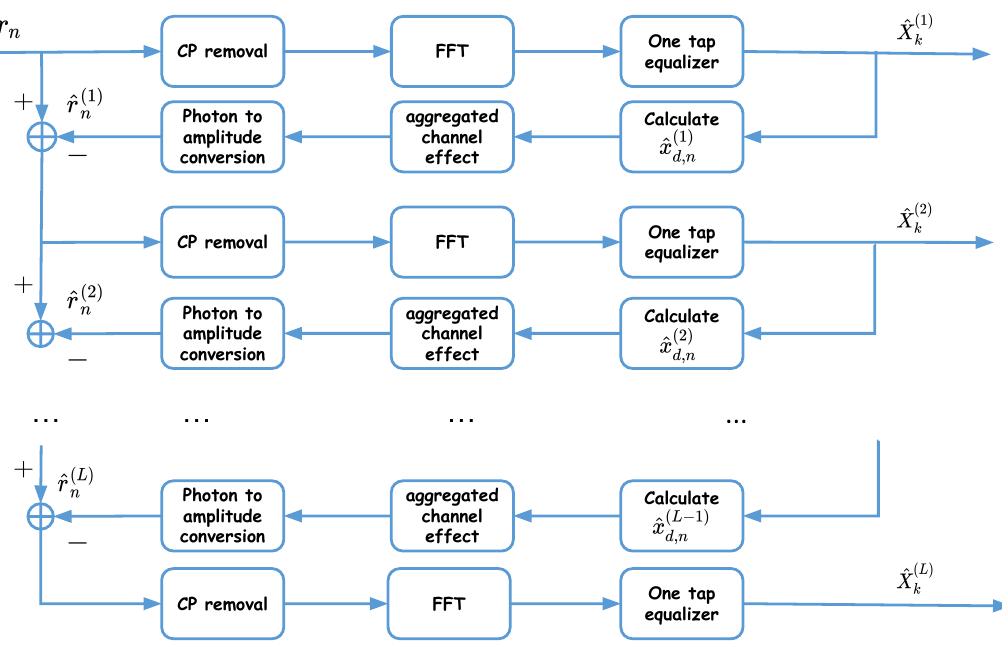
Figure 3. Iterative LACO-OFDM signal detection at the Rx with L